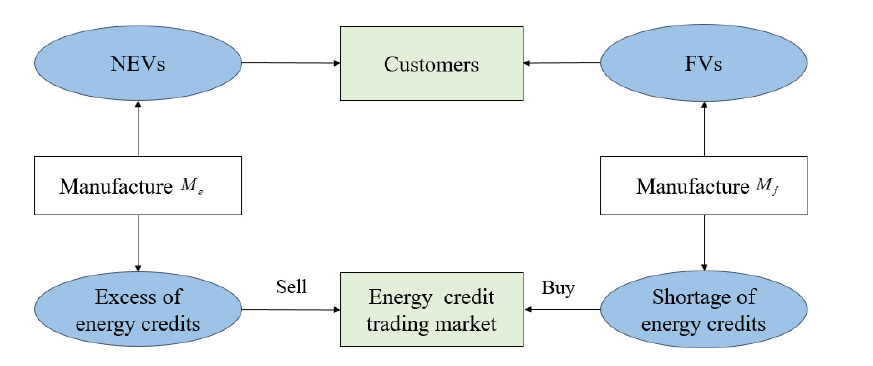
Figure 3. Market structure with energy credit trading